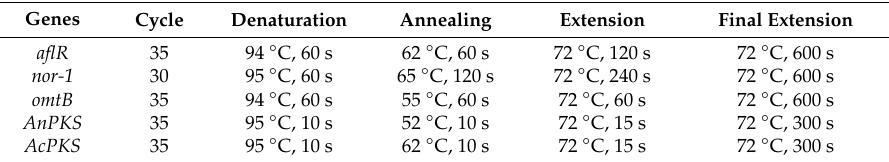
Table 2. Program of Polymerase Chain Reaction for amplification of genes involved in aflatoxin (AF) and ochratoxin A (OTA)